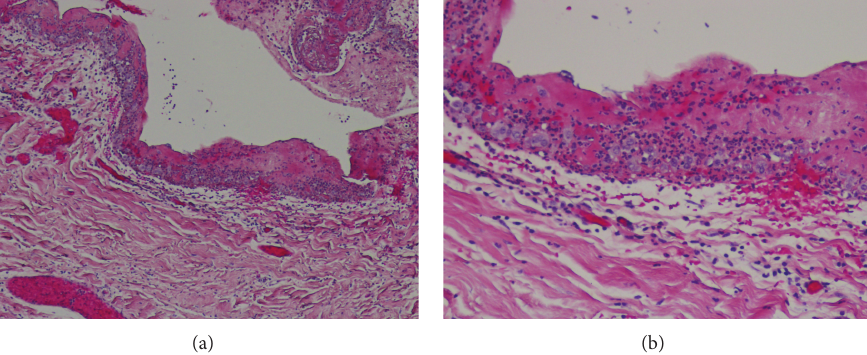
Figure 2: Biopsy specimen from pericardium, sections through the pericardium show acute fibrinous pericarditis, characterized by mixed inflammatory infiltrates in the pericardial wall, accompanied by abundant surface fibrin. No microorganisms were identified on hematoxylin- eosin-stained